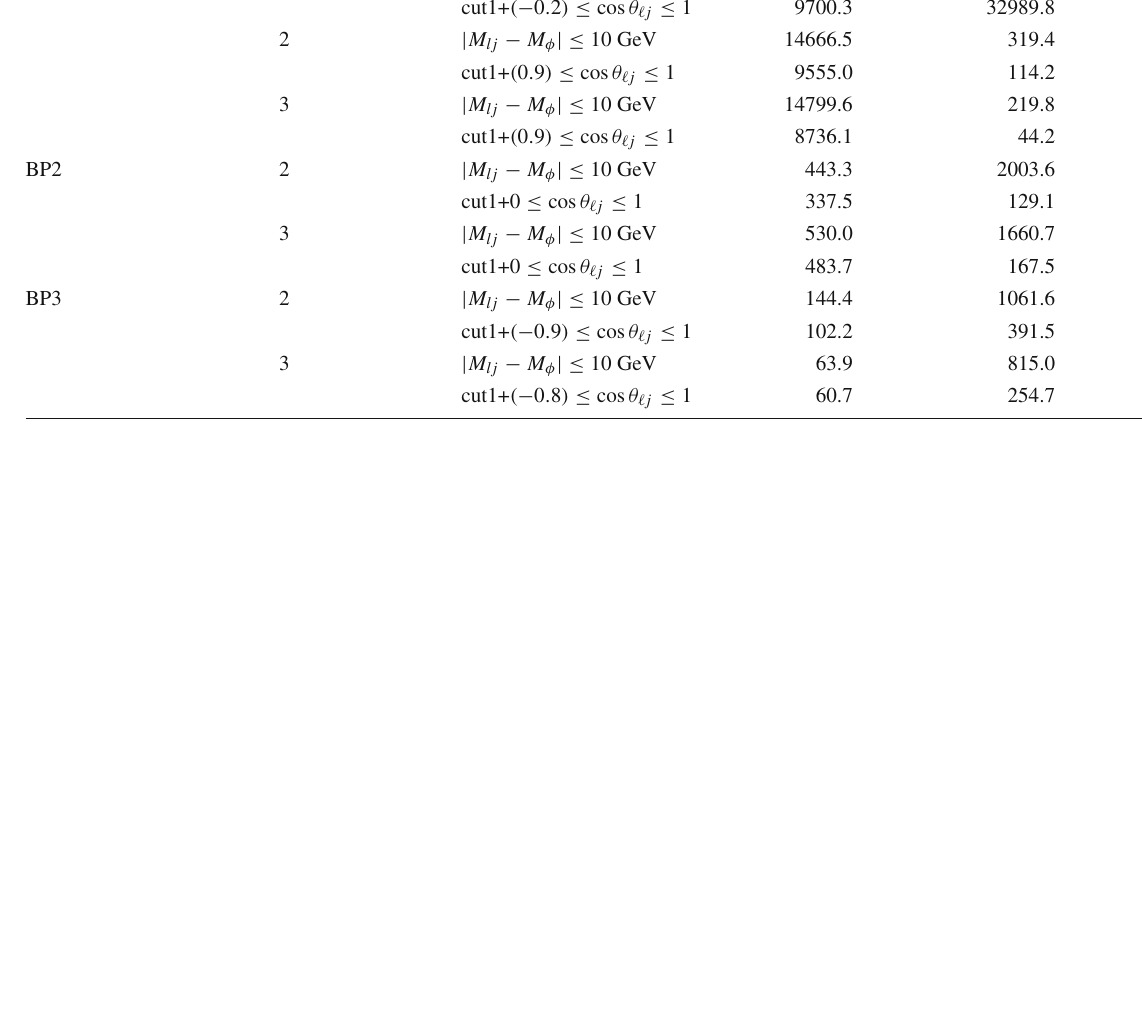
Table 10 Signal-background analysis for ( U + 2 Bench-mark